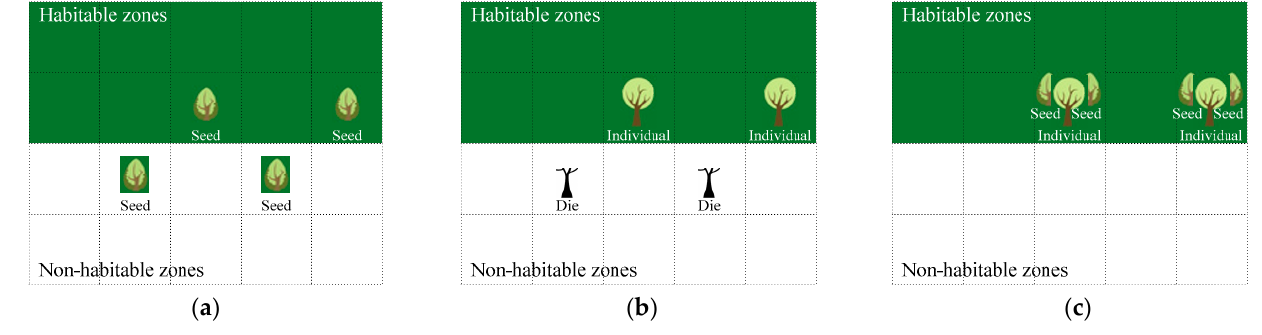
Figure 1. Artificial plant community system [26,49]. ( a ) Seeding; ( b ) growing; ( c ) fruiting.